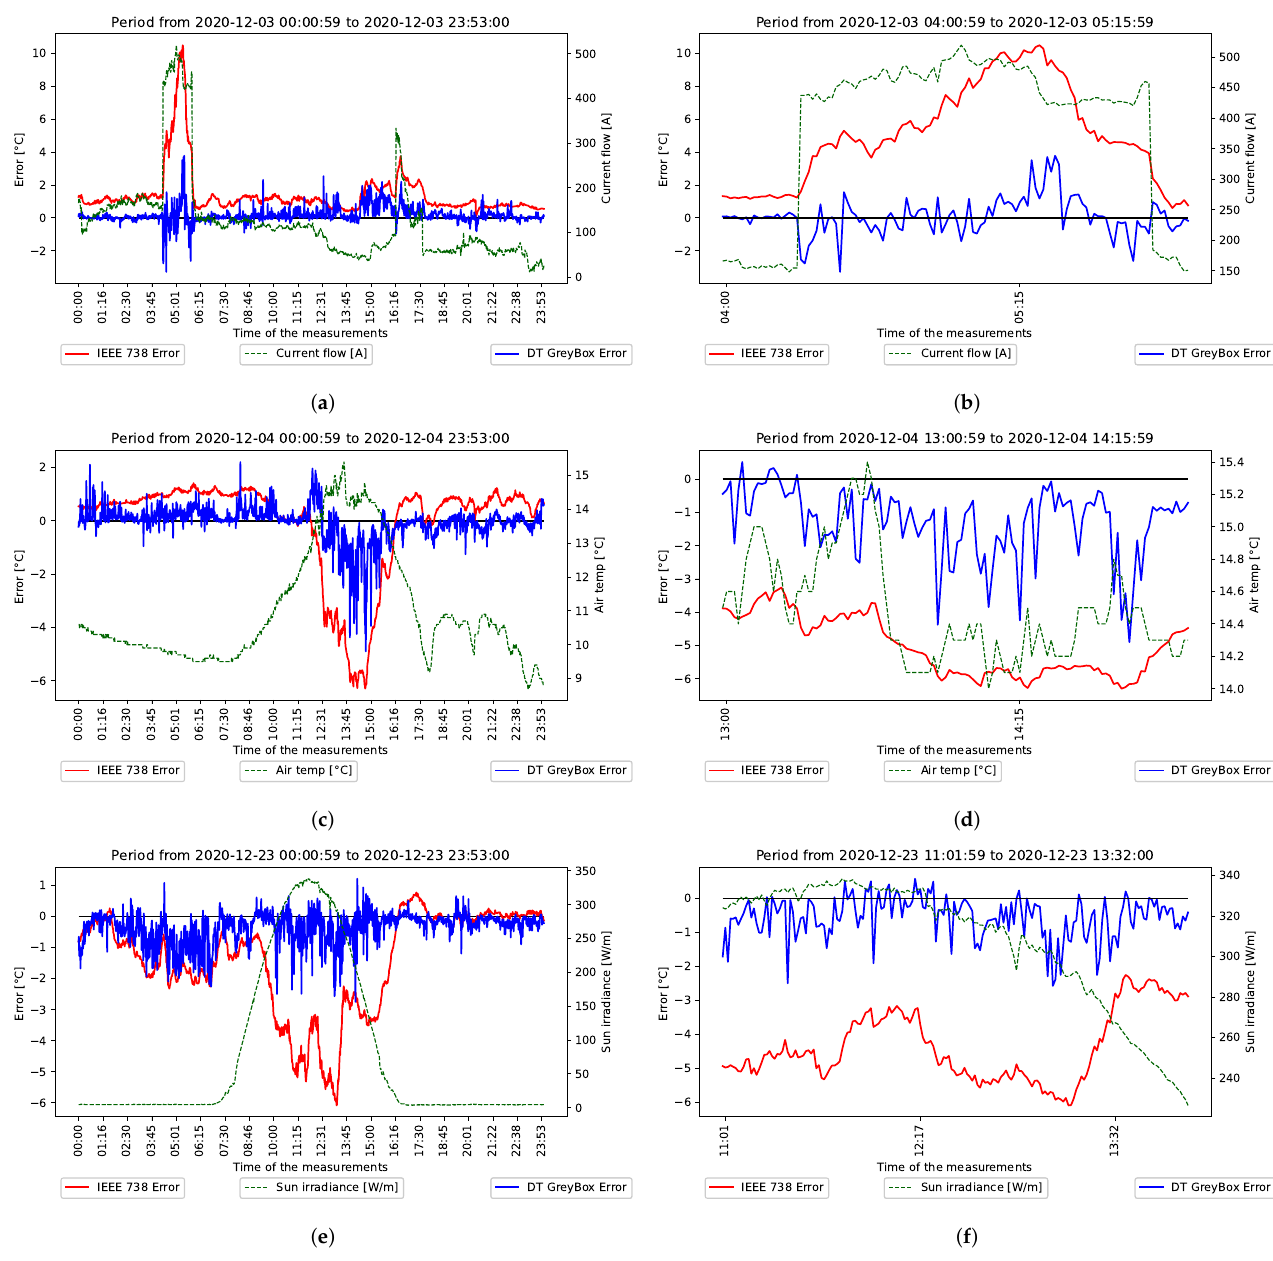
Figure 8. A visualization of the first to third critical areas for the IEEE 738 standard from Table 2. The error Equation (9), is represented for both the IEEE 738 standard and the grey-box proposed approach. Additionally, the most related feature, according to Table 2, is plotted. ( a , b ) report 2020-12-03, where ( b ) is a zoom on the area of interest of ( a ); ( c , d ) report 2020-12-04, where ( d ) is a zoom on the area of interest of ( c ); ( e , f ) report 2020-12-23, where ( e ) is a zoom on the area of interest of ( f ). In all cases, a rapid variation of the measure is most correlated with the error in the moment of its peak.